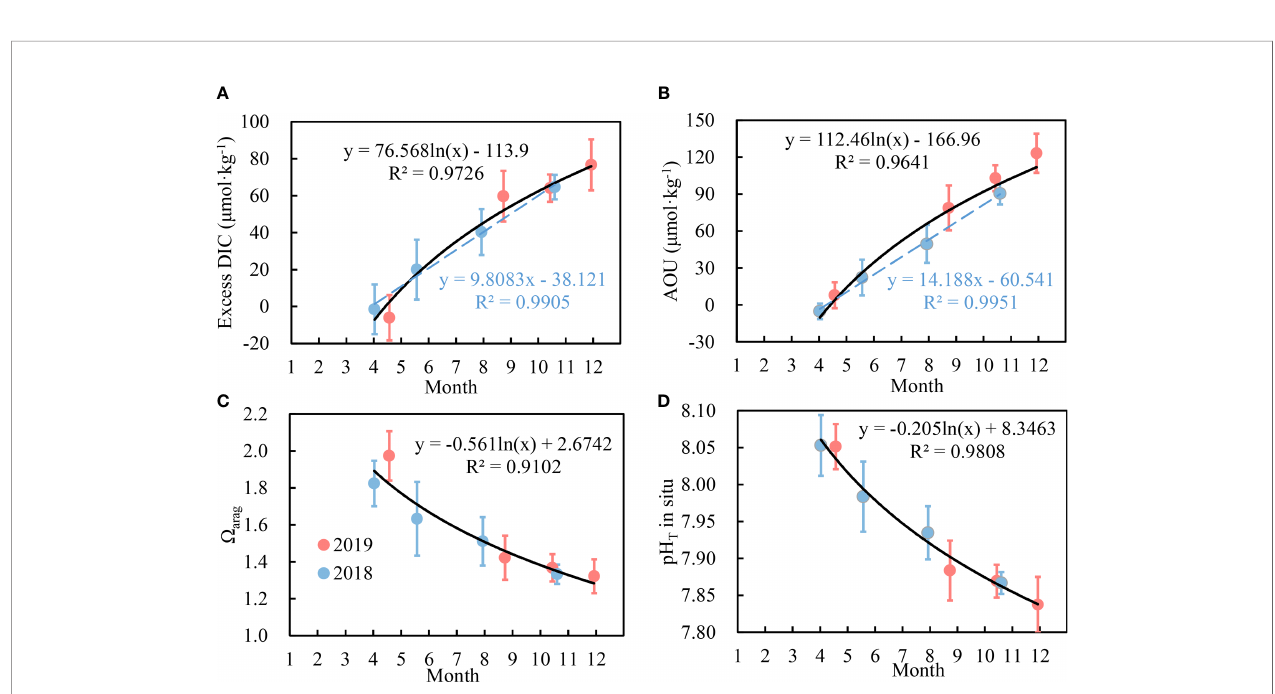
FIGURE 6 | Monthly variations in W arag (D) , pH T (C) , excess DIC (A) and AOU (B) in bottom waters of the SYSCWM. Logarithmic fi tting curves (solid black lines) and the optimal regression equations of parameters versus months were plotted, based on all of eight surveys over 2018 and 2019. The blue dashed lines indicate the optimal linear regression of parameters versus months in